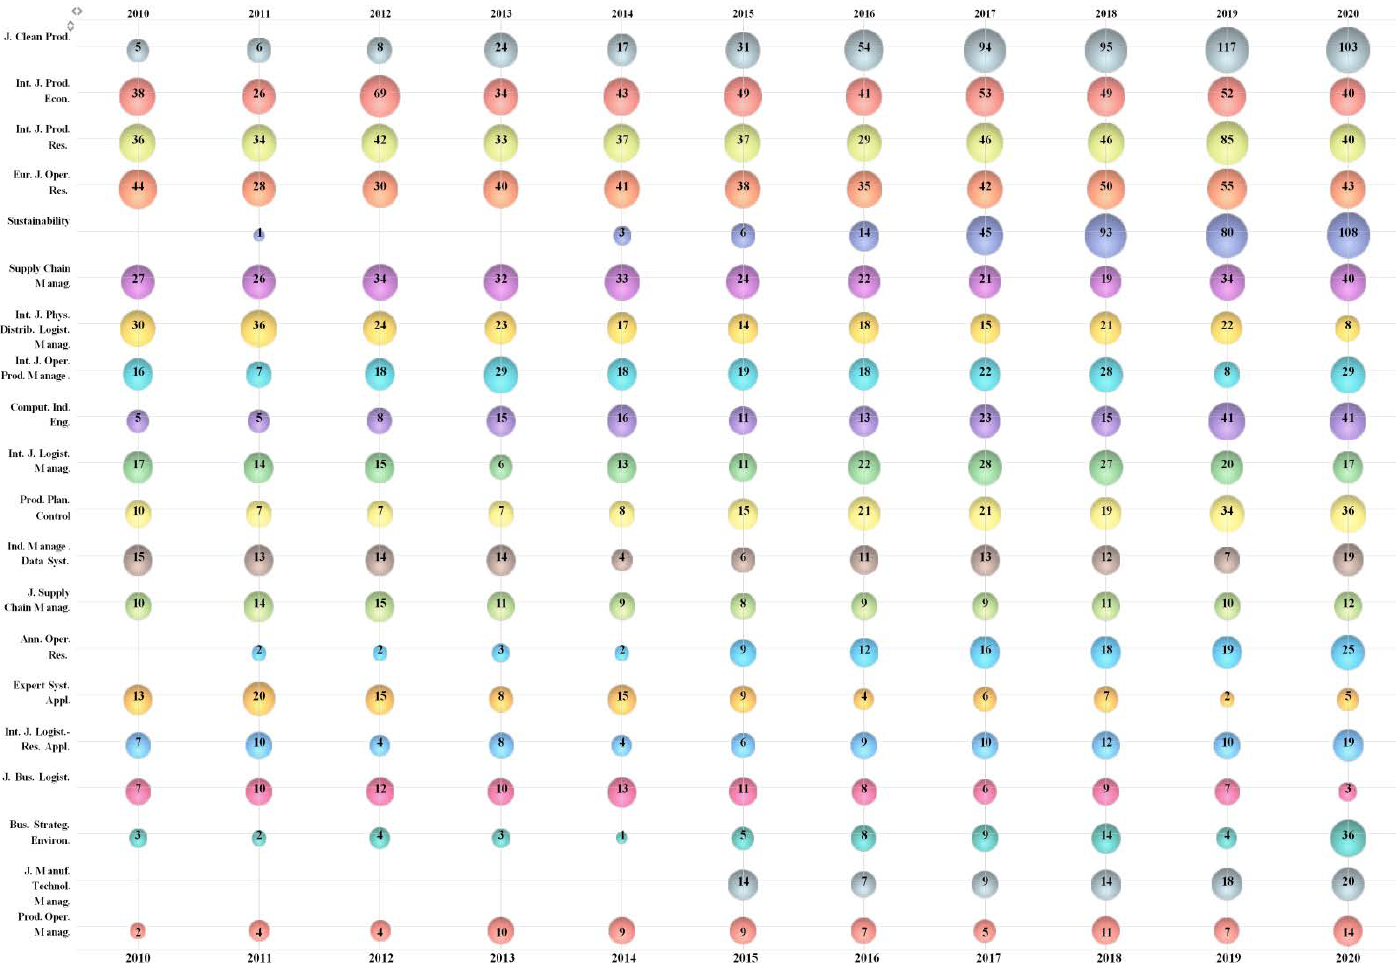
Figure 3. Bubble chart of the top 20 productive journals in SCM.